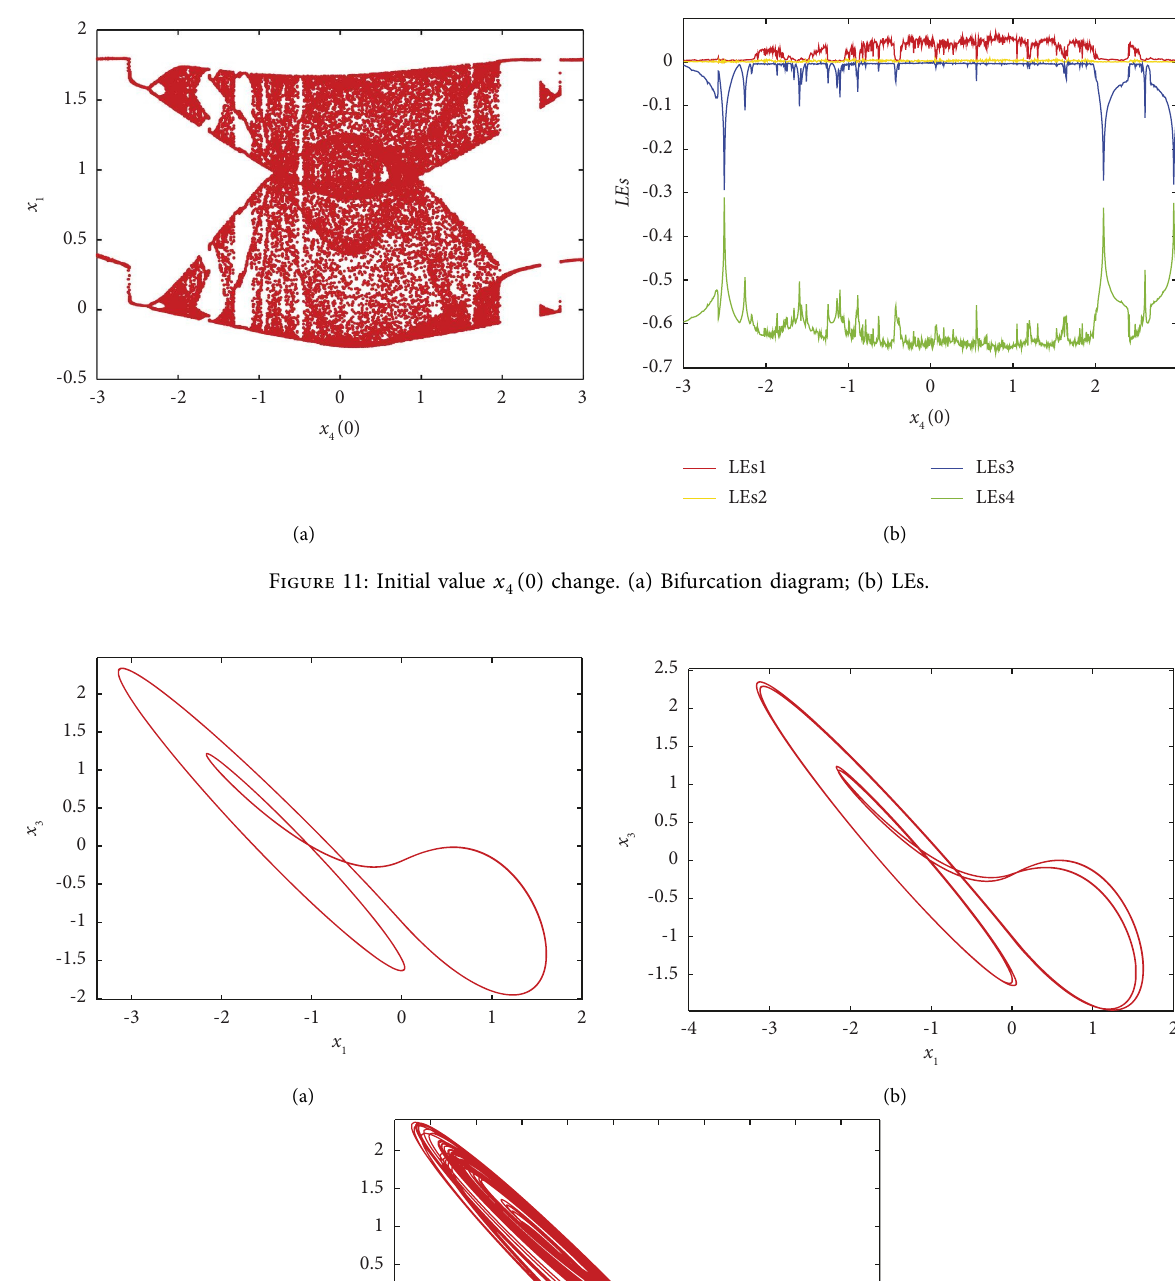
( 0 ) . (a) x ( 0 ) � − 3 is x 4 4